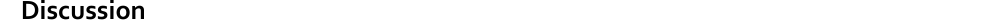
group of genes induced by thinning were involved in carbohydrate metabolism (24.1% in the R5 + 14 d and 9.8% in the R5 + 28 d datasets). However, the GO enrichment analysis of approximately half of the transcriptionally active genes (26,836 genes) with a logarithmic value above -2.0 revealed that the photosynthesis-related genes were not the most overrepresented genes (7.2% in the R5 + 14 d and 6.9% in the R5 + 28 d datasets). This indi- cated that the thinning treatment markedly altered the expression of photosynthesis-related genes in the stem. The filtered and screened DEGs were then compared between the R5 + 14 d and R5 + 28 d datasets and a set of common 19 upregulated and 8 downregulated genes were identified in both the datasets (Table 6). Of the 18 upregulated genes, eight genes were related to photosynthesis, including those encoding the 22 kDa-protein of photosystem II (PsbS), chlorophyll a/b-binding protein (CP24), chloroplast pigment-binding protein (CP26), and early light-induced proteins (ELIPs). The remaining four upregulated genes encode VSPs, such as 28 and